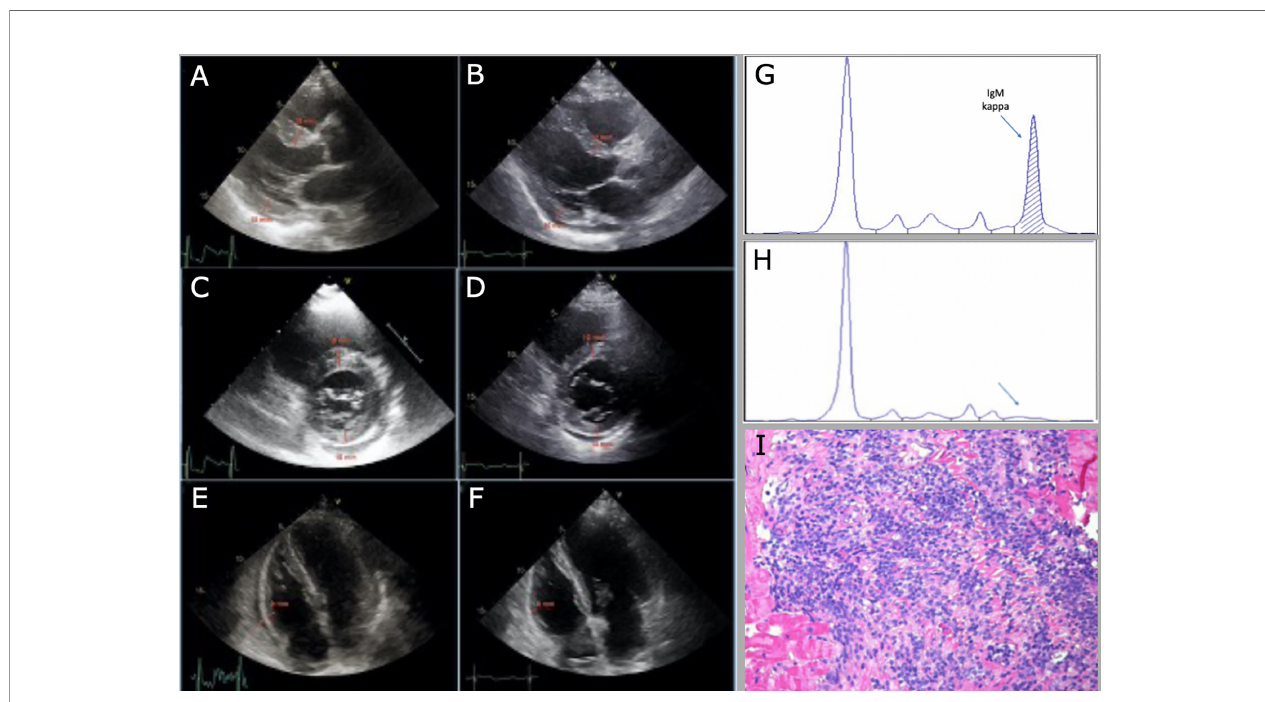
FIGURE 2 | Decrease in cardiac wall thickness after chemotherapy at echocardiographic evaluation (from A to F ). (A, C) interventricular septum (IVS) and posterior wall (PW) thickness, 18 mm and 15 mm respectively, from parasternal long-axis and short-axis view, before chemotherapy. (B, D) IVS and PW thickness, 12 mm and 10 mm, respectively, from parasternal long-axis and short-axis view, after chemotherapy. (E, F) right ventricular lateral wall (RV-LW) thickness, 9 mm and 6 mm, respectively, from 4 chamber view; of note, pericardial effusion decreases from 18 mm to 6 mm after chemotherapy. (G) monoclonal IgM/K before starting treatment. (H) no more detectable monoclonal paraprotein after treatment. (I) histologic sample of endomyocardial biopsy, hematoxylin-eosin